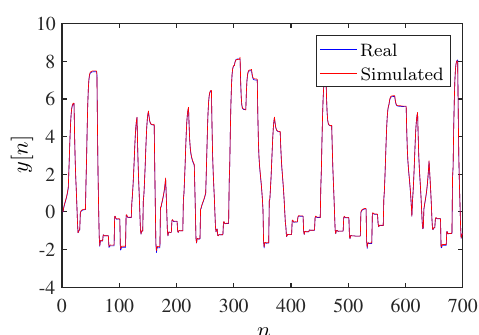
Figure 19. Training